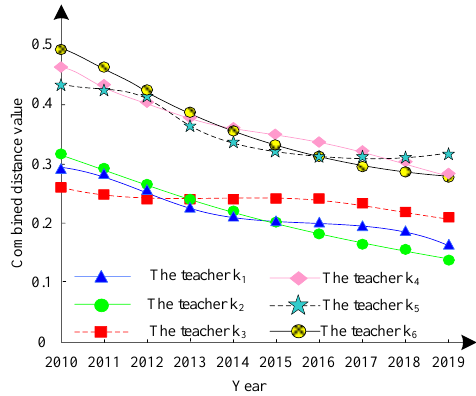
Figure 3. Evaluation results and trends of teachers in three